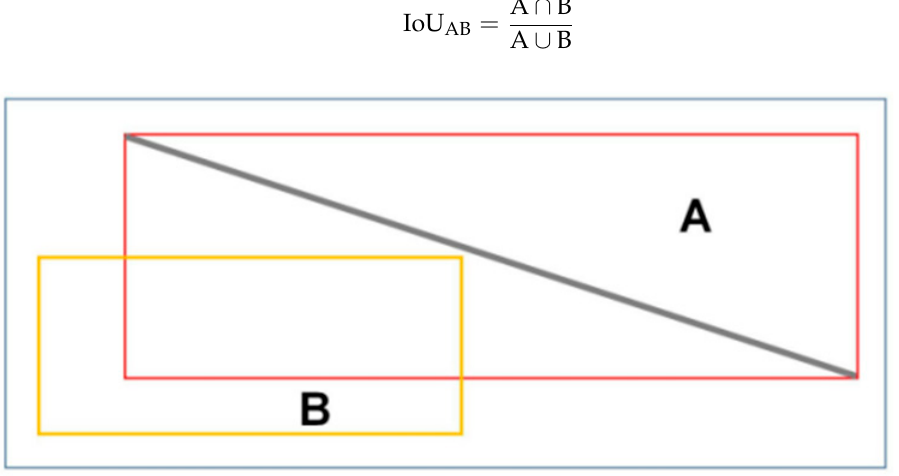
Figure 5. Positive sample misclassification cases. A is the truth box, B is the prediction box.